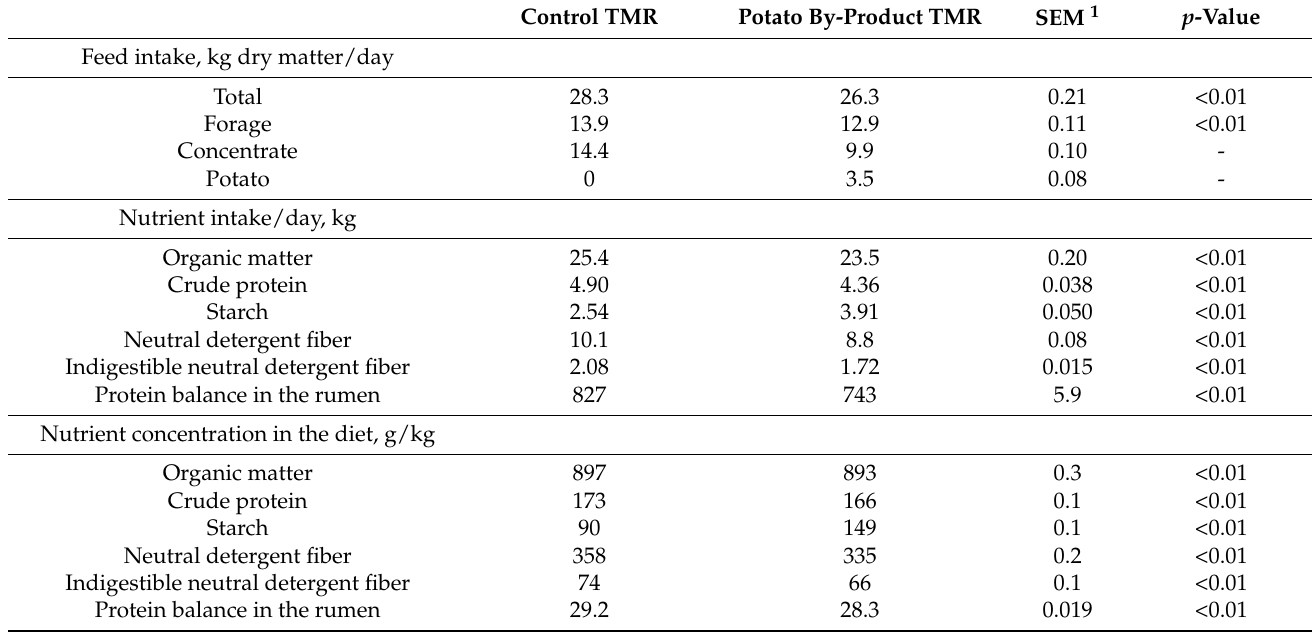
Table 4. Feed and nutrient intake, and nutrient concentrations of the total mixed ration (TMR) diets in the dairy cow feeding experiment (Experiment